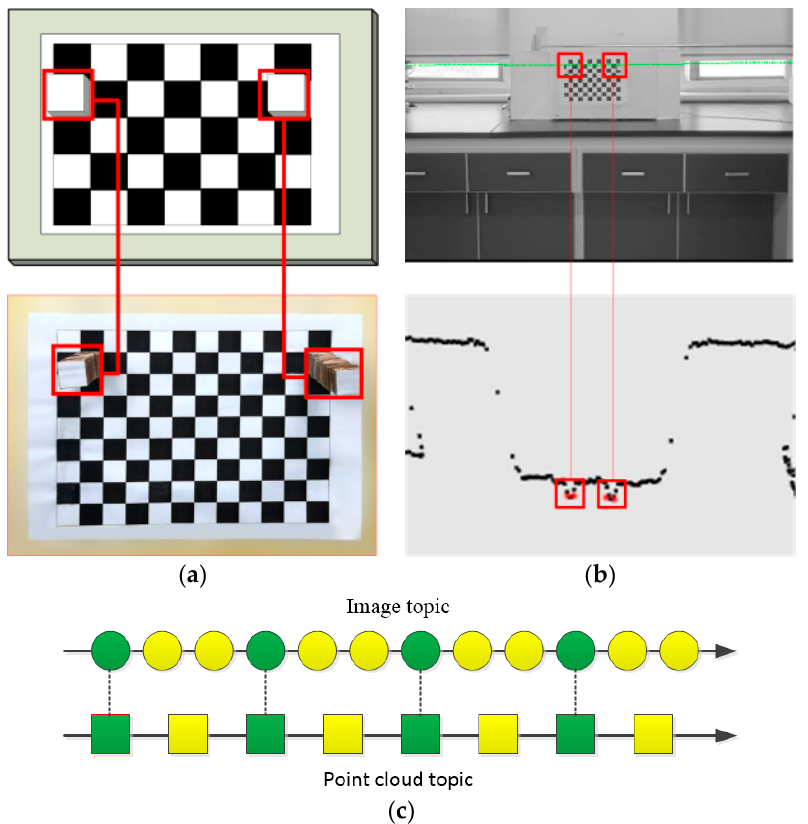
Figure 1. Joint calibration of the monocular vision camera and the 2D Lidar based on space coordinates and time axis conditions. ( a ) 3D calibration board; ( b ) The calibration test; ( c ) The calibration of the vision sensor and the lidar in the time dimension.